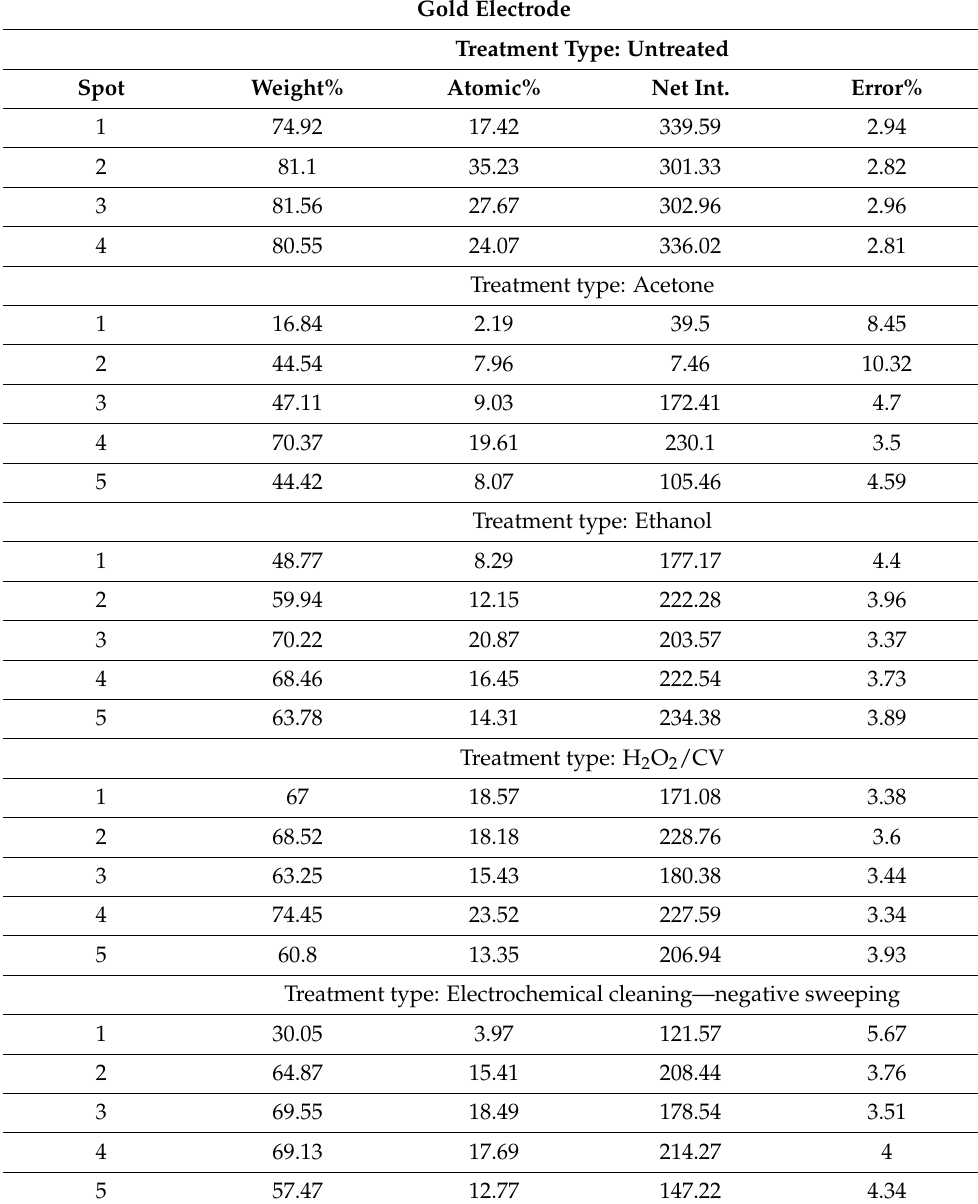
Table 9. The weight of Au per spot fluctuation according to the cleaning